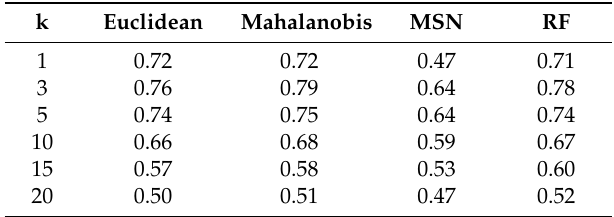
Table 4. Index H for k-NN by number of neighbors (k) and distance metric using the three predictor variables P30, P90, and cover(1.50) and responses TPH and Vol. for all species combined. k Euclidean Mahalanobis MSN RF 1 0.72 0.72